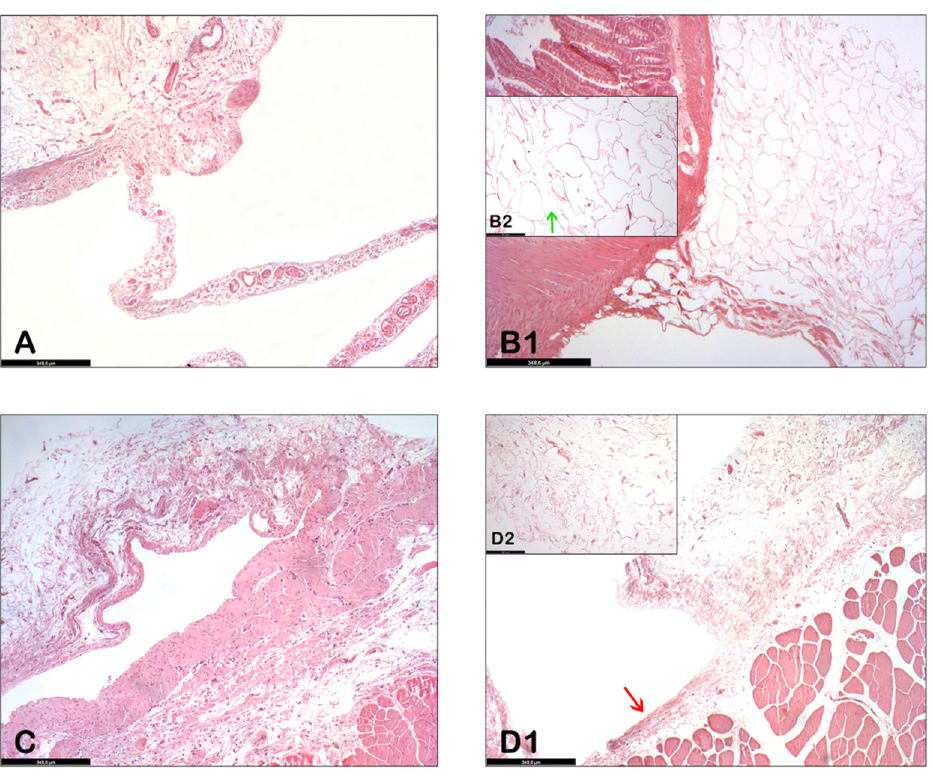
Figure 4. ( A ). Adhesion arising from the small bowel wall in the non-treatment group; ( B1 ). Similar intestinal adhesion after collagenase exposure (hematoxylin-eosin staining, original magnification × 50). ( B2 ). The adipocyte matrix is degraded and the cells are separating from each other (hematoxylin-eosin staining, original magnification × 200); ( C ). End of adhesion in the abdominal wall in the non-treatment group (hematoxylin-eosin staining, original magnification × 50); ( D1 ). Abdominal wall in the collagenase-treated group, visceral walls remain intact after administration of collagenase (red arrow) (hematoxylin-eosin staining, original magnification ×50); ( D2 ). collagen fibers dispersed due to the action of collagenase (hematoxylin-eosin staining, original magnification ×200).